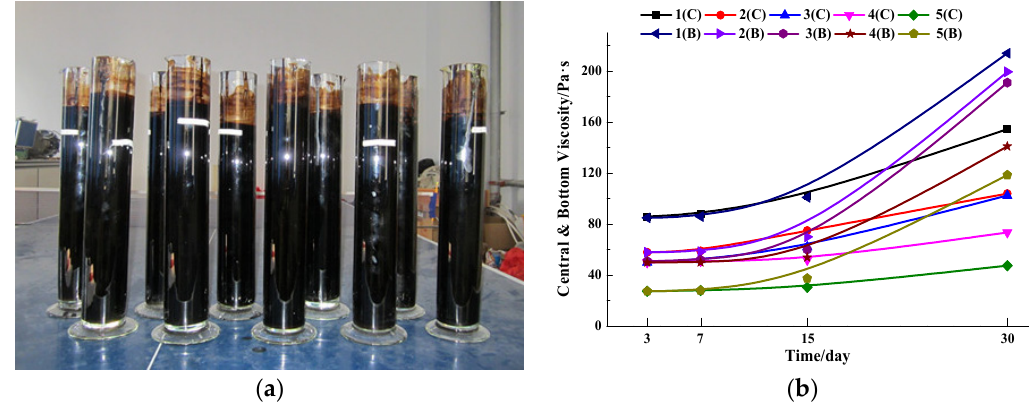
Figure 4. Storage stability contrast test. ( a ) Storage stability samples; ( b ) Viscosity contrast results.